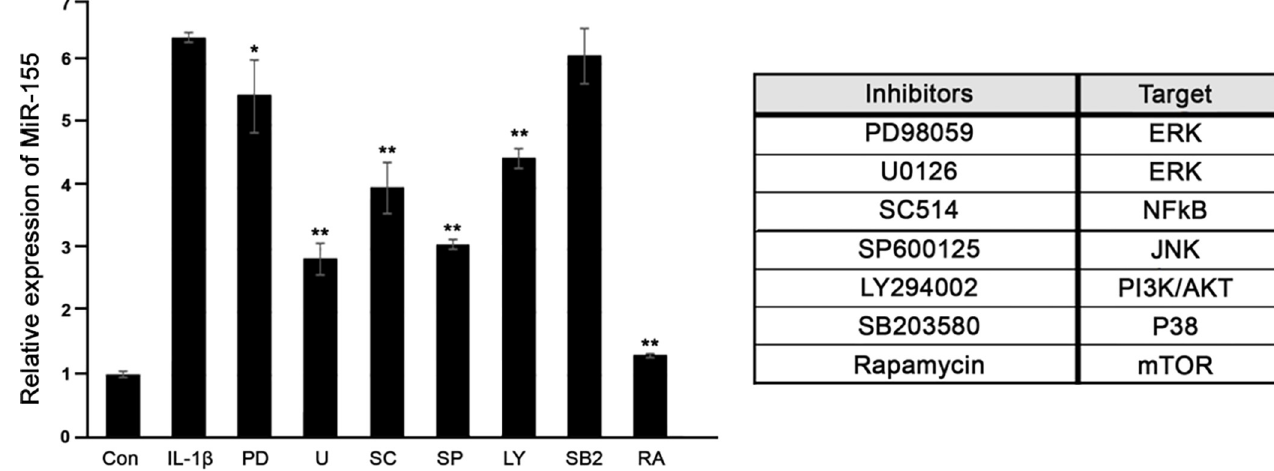
Fig 6. Effects of inhibitors of extracellular signal-regulated kinase, nuclear factor kappa-light-chain-enhancer of activated B cell, c-Jun N-terminal kinase, phosphatidylinositol 3-kinase/Akt, P38 mitogen activated protein kinase, and mammalian target of rapamycin on microRNA-155 expression in Graves’ orbitopathy (n = 3) orbital fibroblasts. ( � P < 0.05, �� P < 0.01).